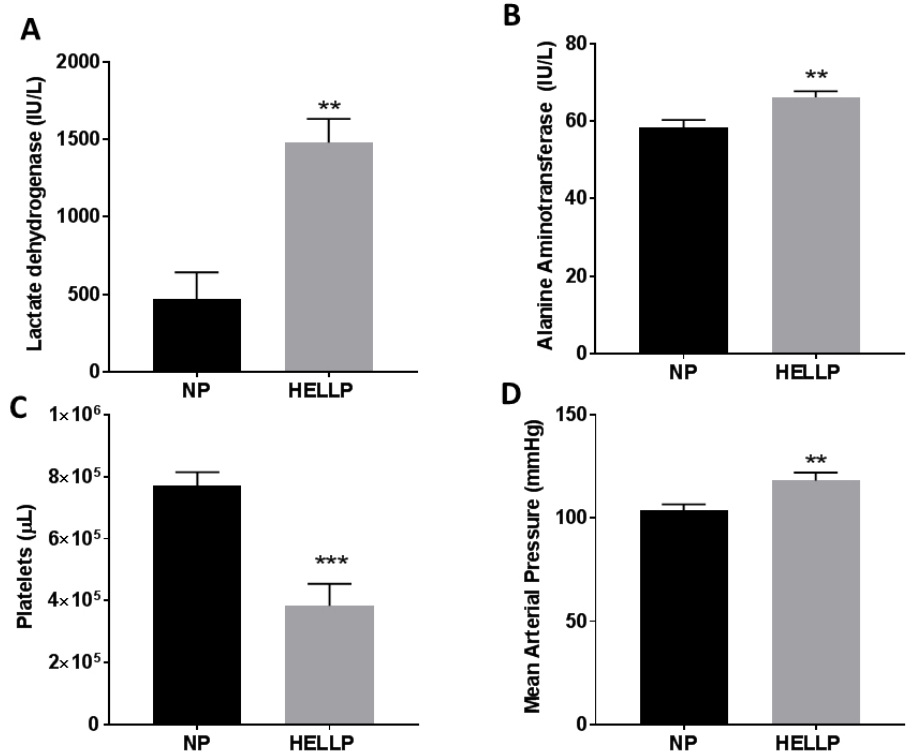
Figure 1. The biochemical factors associated with hemolysis elevated liver enzymes and low platelets (HELLP) syndrome were significantly increased and decreased, respectively, when sFlt-1 and sEndoglin were infused into normal pregnant (NP) rats. Hemolysis (measured by lactated dehydrogenase, ( A )) and liver enzymes (alanine aminotransferase, ( B )) were significantly increased compared to NP rats, and platelets were significantly decreased ( C ). Mean arterial pressure was also significantly increased in HELLP rats when measured via carotid catheter at gestational day 19 ( D ). **, *** denotes p < 0.05, 0.001 compared to NP. n = 16/group.